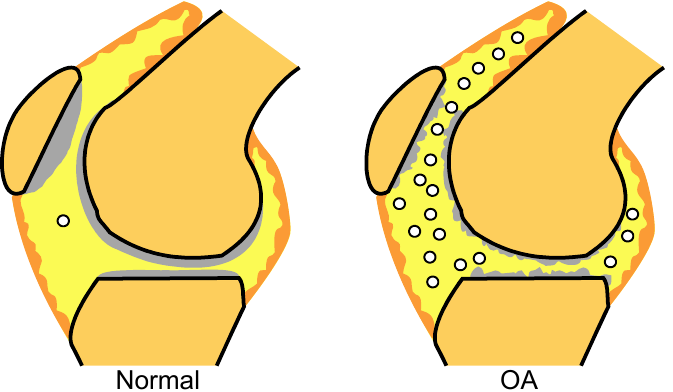
Figure 5. MSCs in synovial fluid. MSCs in synovial fluid are seldom detected in normal knees but are found in greater numbers in OA knees.